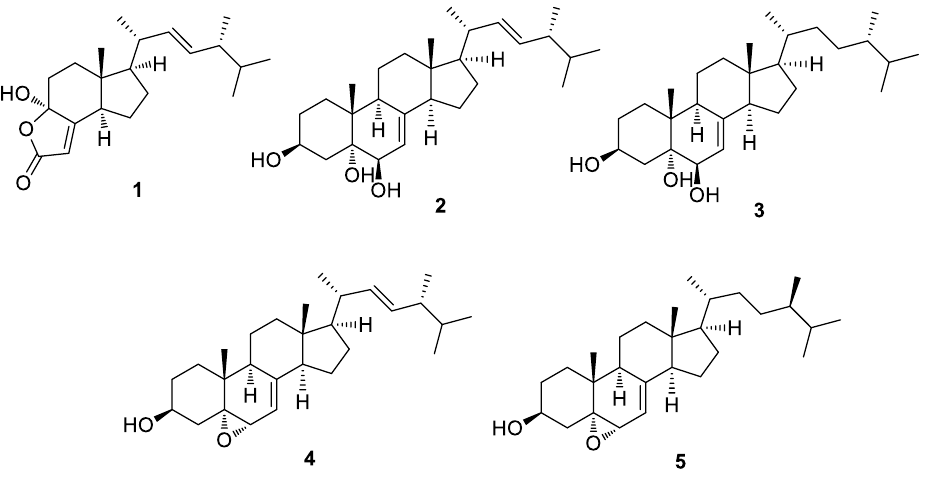
Figure 3. Chemical structures of compounds 1 – 5 .